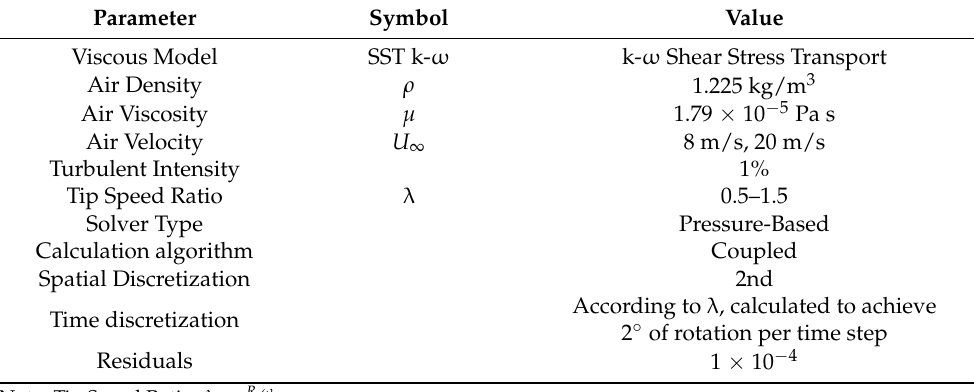
Table 3. Details of Numerical